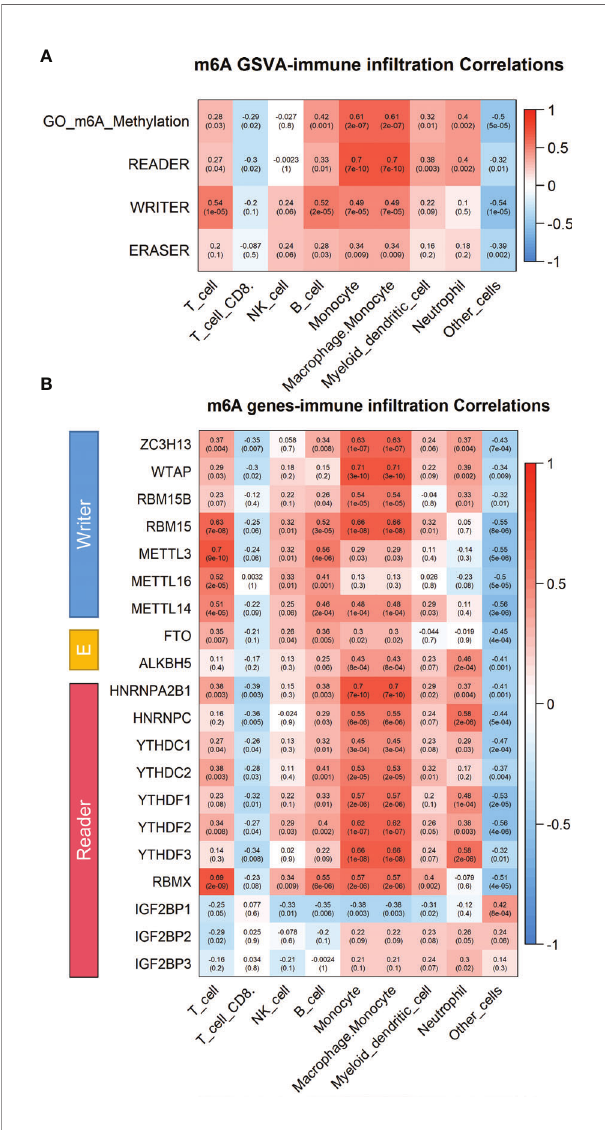
FIGURE 4 | Correlation between immune in fi ltrating cell types and m 6 A modi fi cation in peripheral blood immune cells of CRC patients. (A) Heatmap of correlation between immune in fi ltrating cell types and m 6 A modi fi cation pathways in peripheral blood of CRC patients by Gene set variation analysis by GSVA ( n = 59). (B) Heatmap of correlation between immune in fi ltrating cell types and m 6 A modi fi cation related gene in peripheral blood of CRC patients by